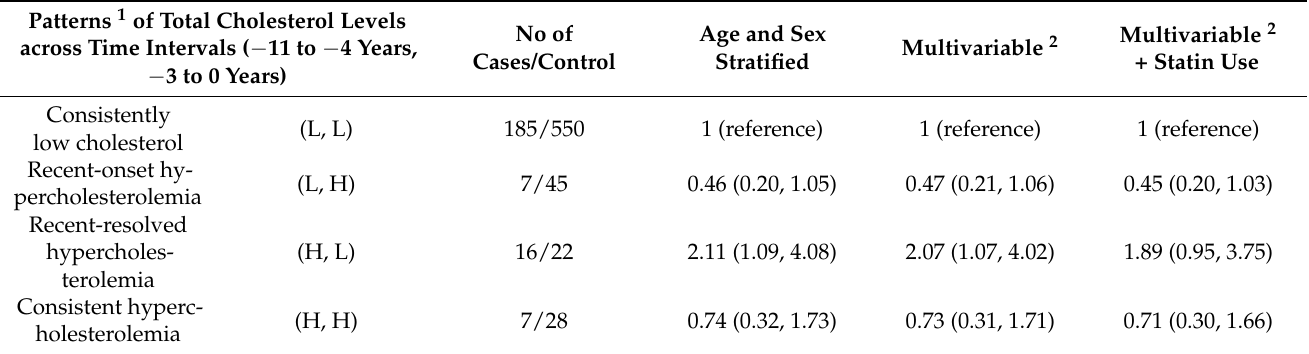
Table 3. Odds ratios and 95% confidence intervals of pancreatic cancer by patterns of total cholesterol levels at different time